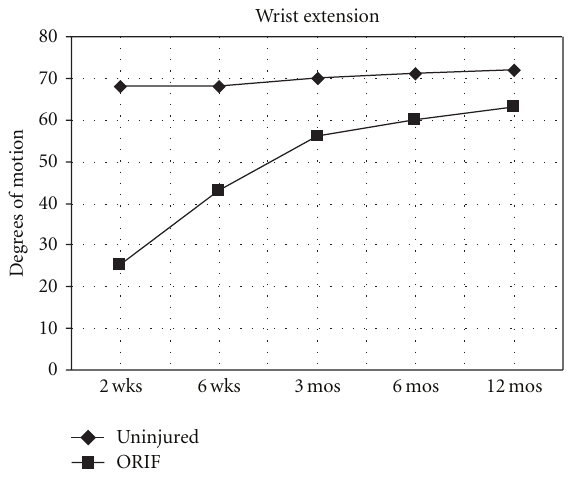
Figure 1: Mean wrist extension measured in degrees at follow-up clinical visits for noninjured wrist and for wrist with an unstable fracture of the distal radius treated with open reduction and internal fixation with a volar fixed-angled plate.